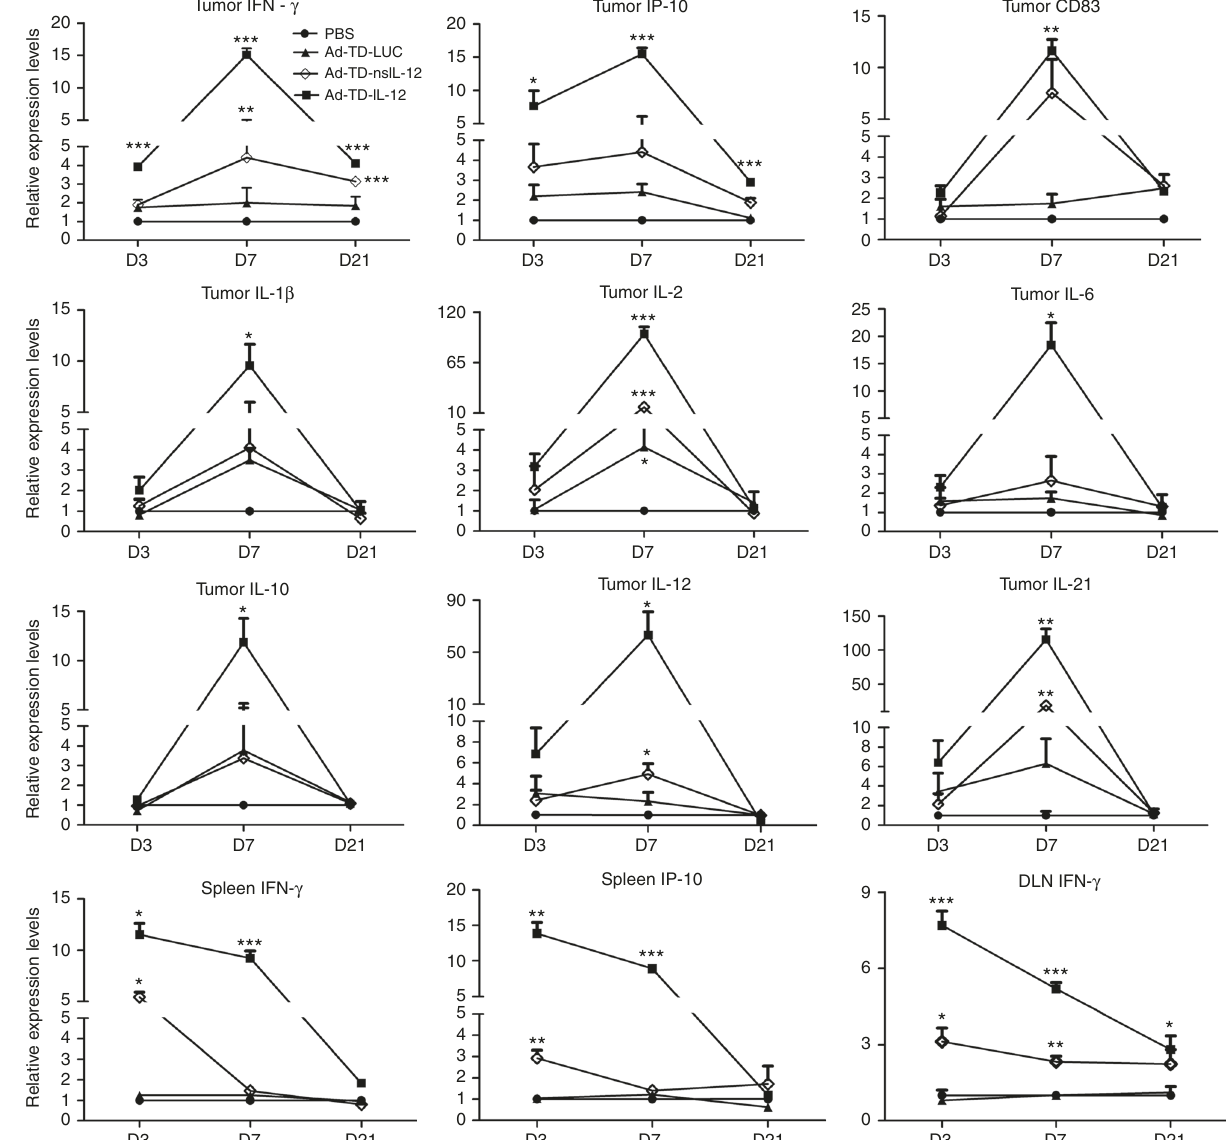
Fig. 8 Ad-TD-nsIL-12 ef fi cacy is mediated by production of in fl ammatory mediators. 2 × 10 6 HPD1NR cells were seeded into the right fl ank of Syrian hamsters. When tumor volumes reached 300 mm 3 , nine hamsters per group were each injected i.t with 100 µ l PBS, 1 × 10 9 PFU Ad-TD-LUC or Ad-TD- IL- 12/nsIL-12 on day 0. Spleens, draining lymph nodes (DLN) and tumors were collected and analyzed by qPCR to analyze expression levels of CD83, IFN- γ , IP10, IL-1 β , IL-2, IL-6, IL-10, IL-12, and IL-21 at the indicated time points. All experiments were performed in triplicate and the mean and SEM are shown for each group compared using an independent t-test. * p < 0.05, ** p < 0.01, *** p < Four days later, 10 hamsters per group were injected i.p with 500 µ l PBS, 1× 10 9 injected i.p with anti-CD3 mAb on the day before the re-challenge with 4× 10 6 PFU Ad-TD-LUC or 5× 10 8 PFU Ad-TD-IL-12 or 1 ×10 9 PFU Ad-TD-nsIL-12 on HPD-1NR cells. Tumor volumes were measured twice weekly. SHCP6 cell re- days 0, 2, 4. Alternative doses were given as indicated in the text or fi gure legend. challenge is described in the fi gure legend. The survival of hamsters was monitored. CD3 and CD4 depletion in vivo . A total of 2 ×10 6 HPD-1NR cells were implanted Hepatotoxicity evaluation . Three hamsters per group per time point were injected subcutaneously into 4-week to 5-week-old Syrian hamsters. When tumors reached i.p with 1 ×10 7 SHPC6 cells. Four days later, nine hamsters per group were each 300 mm 3 , hamsters were distributed between the treatment and the control groups injected i.p with 500 µ l PBS, 1× 10 9 PFU Ad-TD-LUC or 5× 10 8 PFU Ad-TD-IL- by matched tumor size to receive i.t injections of 1 × 10 9 PFU Ad-TD-nsIL-12 or 12 or 1× 10 9 PFU Ad-TD-nsIL-12 on days 0. Blood was collected from hamsters PBS on day 0, 2, 4, 6, 8, and 10. Depletion mAb against Syrian hamster CD3 (clone 4F11), mAb against mouse CD4 or control Ig (mouse anti-KLH mAb) were from the retro-orbital sinus, and the sera were analyzed for transaminase levels and administered i.p with doses of 500 μ g/injection every fourth day from the day IL-12 expression on day 1, 3, 5. before the virotherapy to the end of the experiment and FACS analysis used to con fi rm depletion. Tumor volumes were measured as in the ef fi cacy experiments. Re-challenge of tumor free animals . The hamsters that underwent complete subcutaneous tumor regression following Ad-TD-IL-12 or Ad-TD-nsIL-12 treat- Statistical analysis . Statistical analysis was carried out using Graph Pad Prism 5 ment were re-challenged with 4× 10 6 HPD-1NR cells (twice the number of cells and SPSS 19.0 software. The results were represented as mean ± standard or compared to the primary tumor cell inoculation) or 5× 10 6 HaK cells after primary deviation (SD) or ± standard error of the mean (SEM). Differences between tumors had not been detected for 1 month. One group of the cured animals were